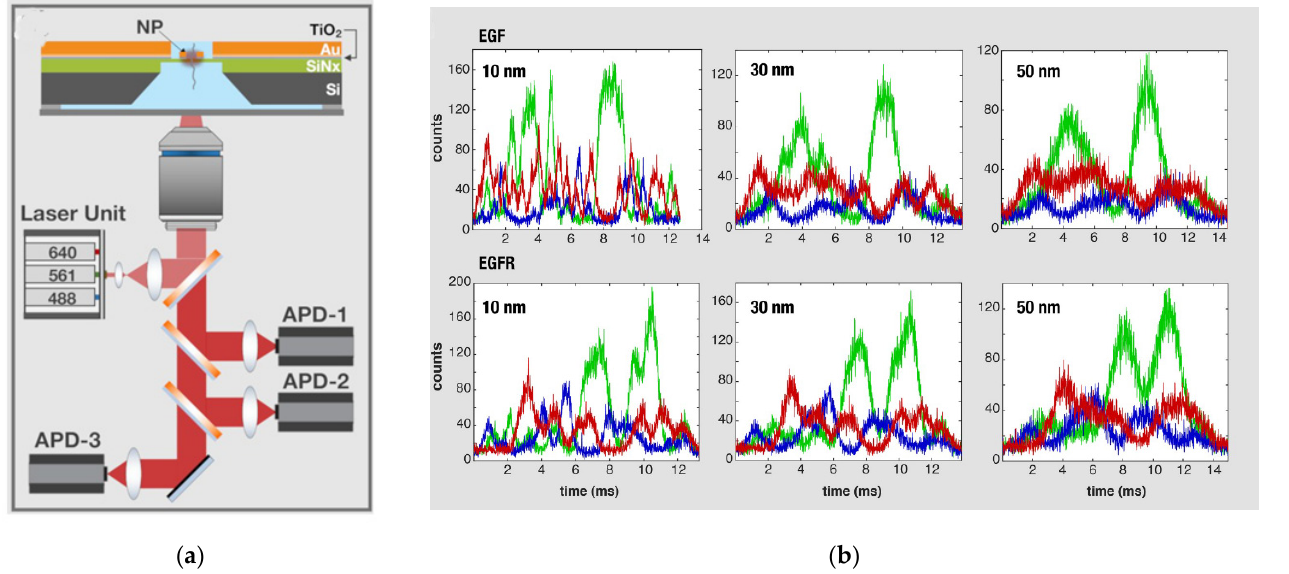
Figure 7. ( a ) Schematics of the nanopore chip and optical system, which includes a high numerical apertures water immersion objective lens, three excitation laser lines and corresponding Silicon avalanche photodiodes (APDs). The nanopore chip is made of four consecutive layers: silicon (grey), silicon nitride (green) in which the nanopore is drilled, titanium oxide (grey blue) and gold (orange); ( b ) optical signals simulated using three distinct spatial resolutions: 10, 30 and 50 nm (from left to right). Adapted with permission from Ohayon et al. [40] Copyright © 2019 PLOS.